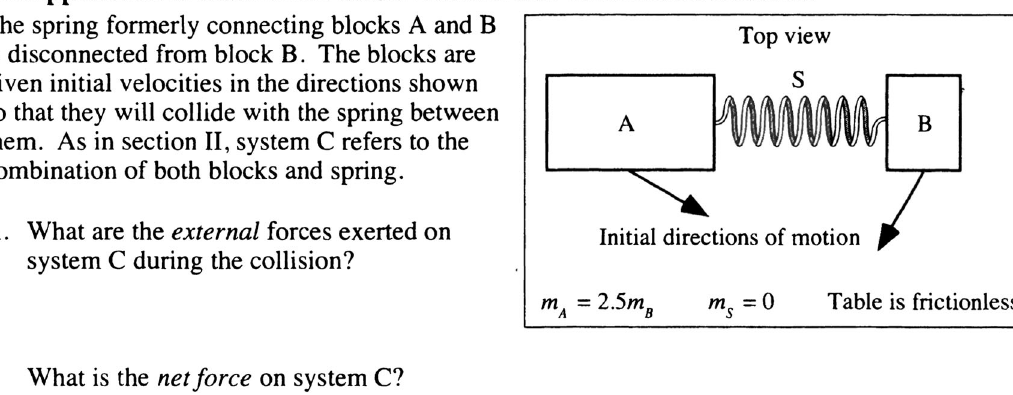
FIG. 4. An example of a short-answer question from McDermott et al. [24]. Data can be coded in various forms, though asymmetric nominal is the most